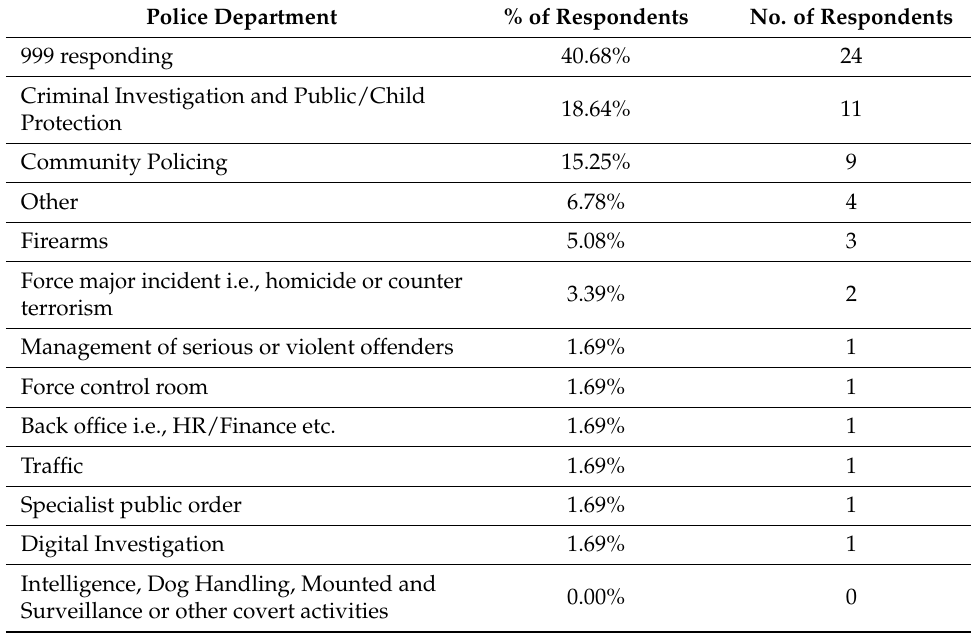
Table 2. No. of survey respondents by